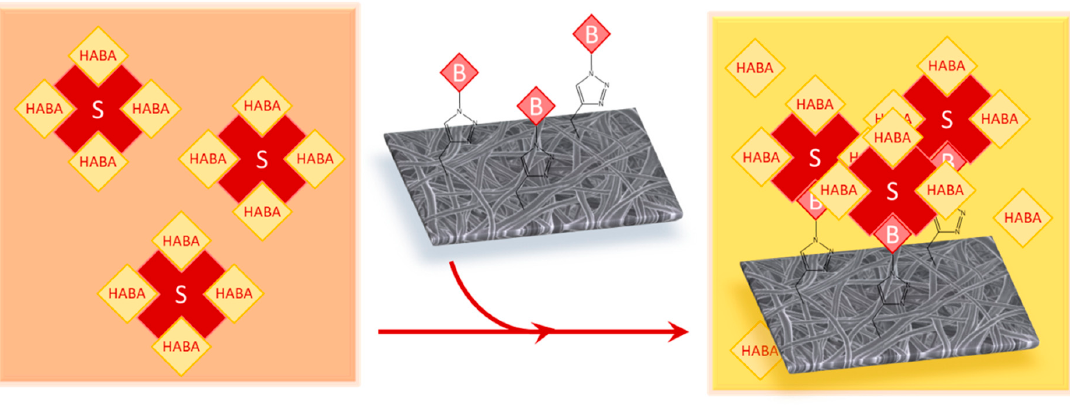
Figure 5. HABA (4'-hydroxyazobenzene-2-carboxylic acid) colorimetric assay: Streptavidin forms a complex with HABA molecules initially. Once biotinylated membrane is added to the mixture, the streptavidin will favorably bind with the available biotin. The change in absorbance at 500 nm correlates to the surface-available biotin.